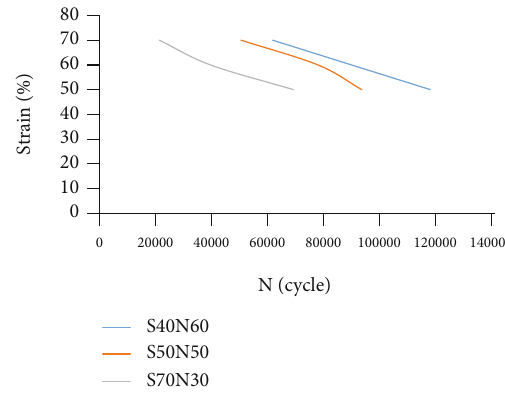
Figure 2: Strain-life of the di ff erent compounds at 50%, 60%, and 70% strain amplitude.